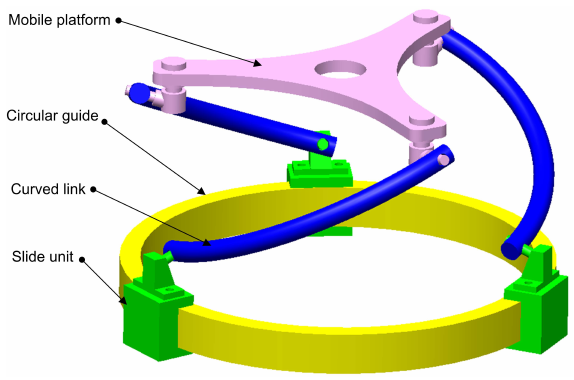
Figure 1: A co-axial spherical parallel manipulator.